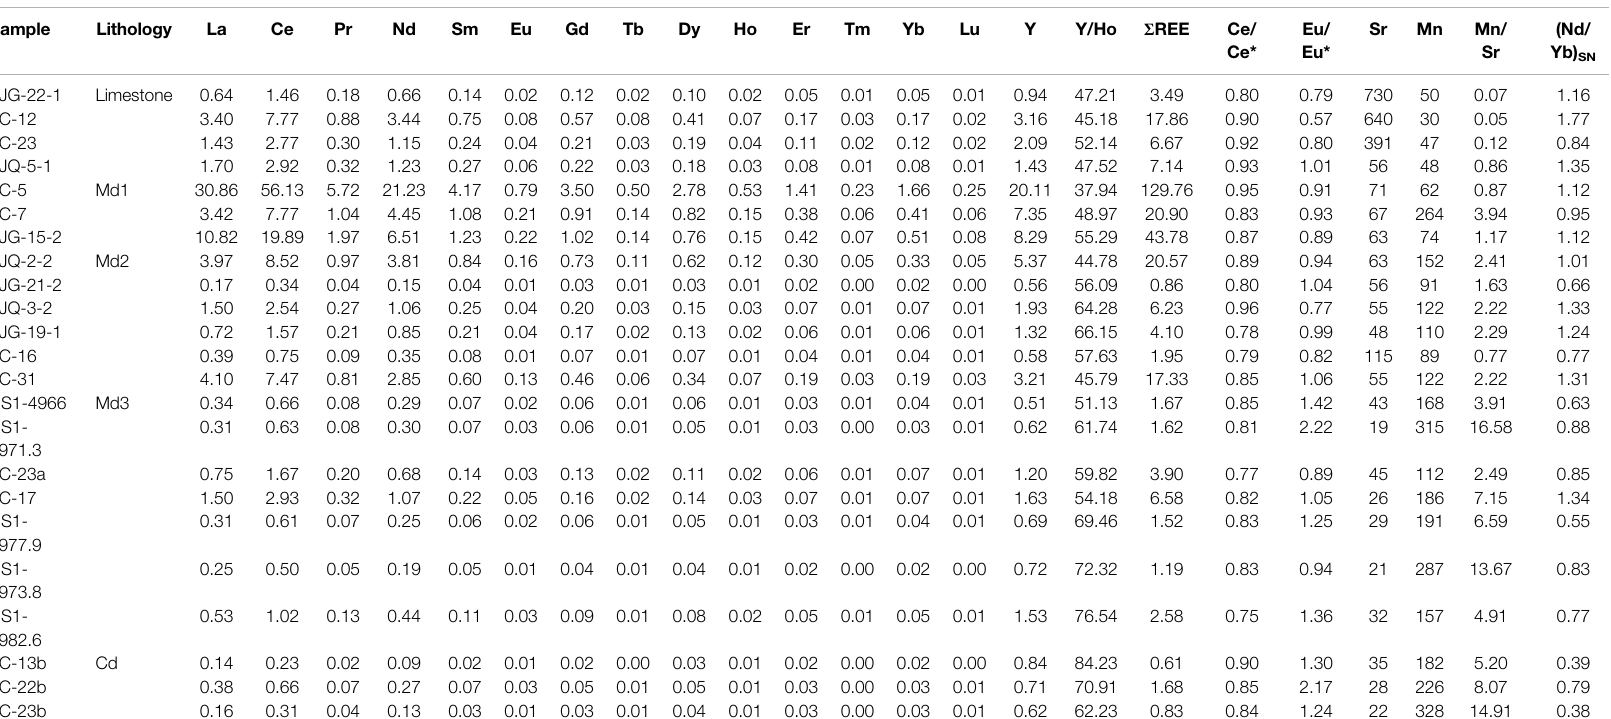
TABLE 3 | Major and trace elements data for Middle Permian carbonates of the southwestern (SW) study area (10 − 6 mg/g).